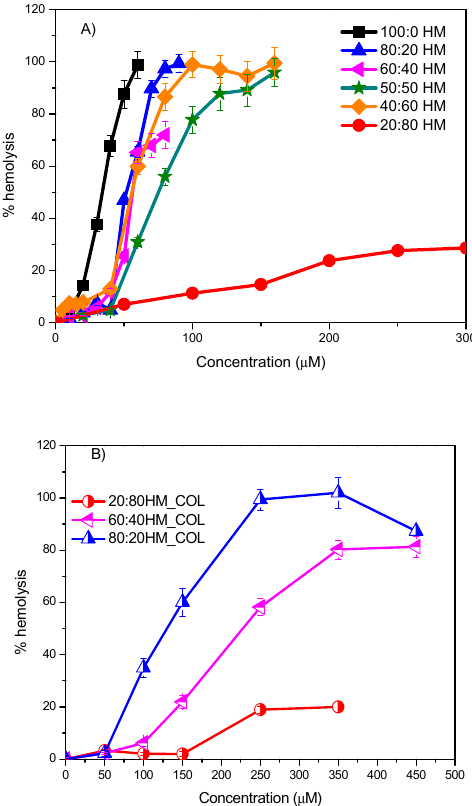
Figure 7. Plots of percentage of haemolysis versus concentration for ( A ) the pure DMHNHC14 and their HM mixtures and ( B ) the HM cholesterol containing their HM mixtures and ( B ) the HM cholesterol containing formulations.